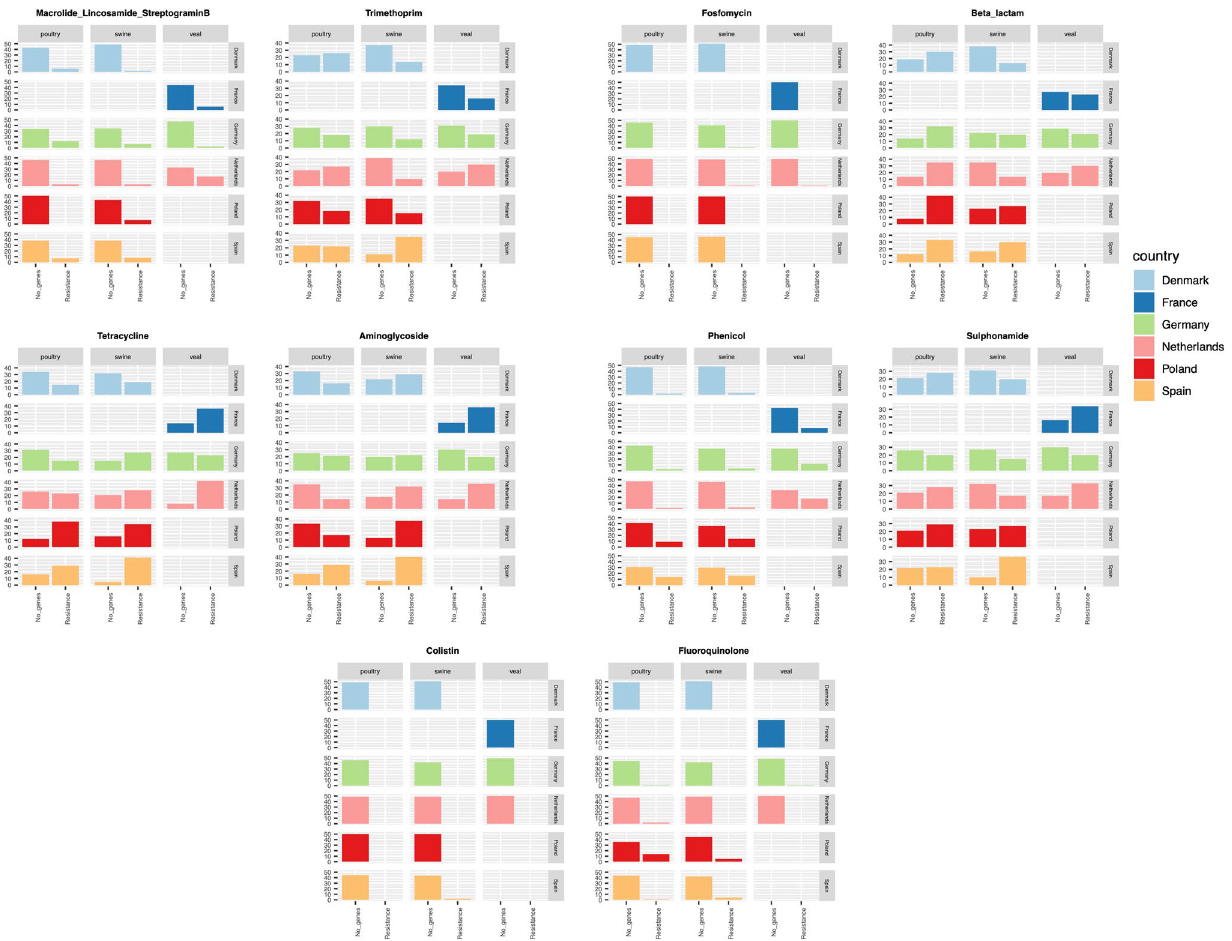
Figure 4. Distribution of resistance and susceptible E. coli isolates in different AMR class and host. Y-axis is number of isolates. Three columns are number of isolates from poultry, swine and veal. In each column, first bar is number of susceptible isolates and second bar is number of resistant